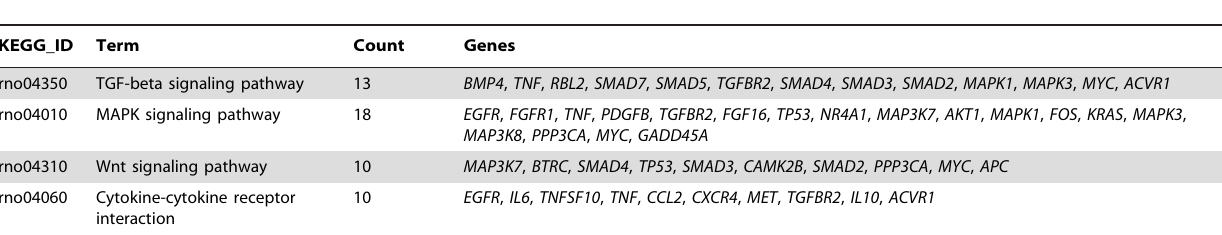
Table 4. Validated target genes grouped by KEGG pathway.